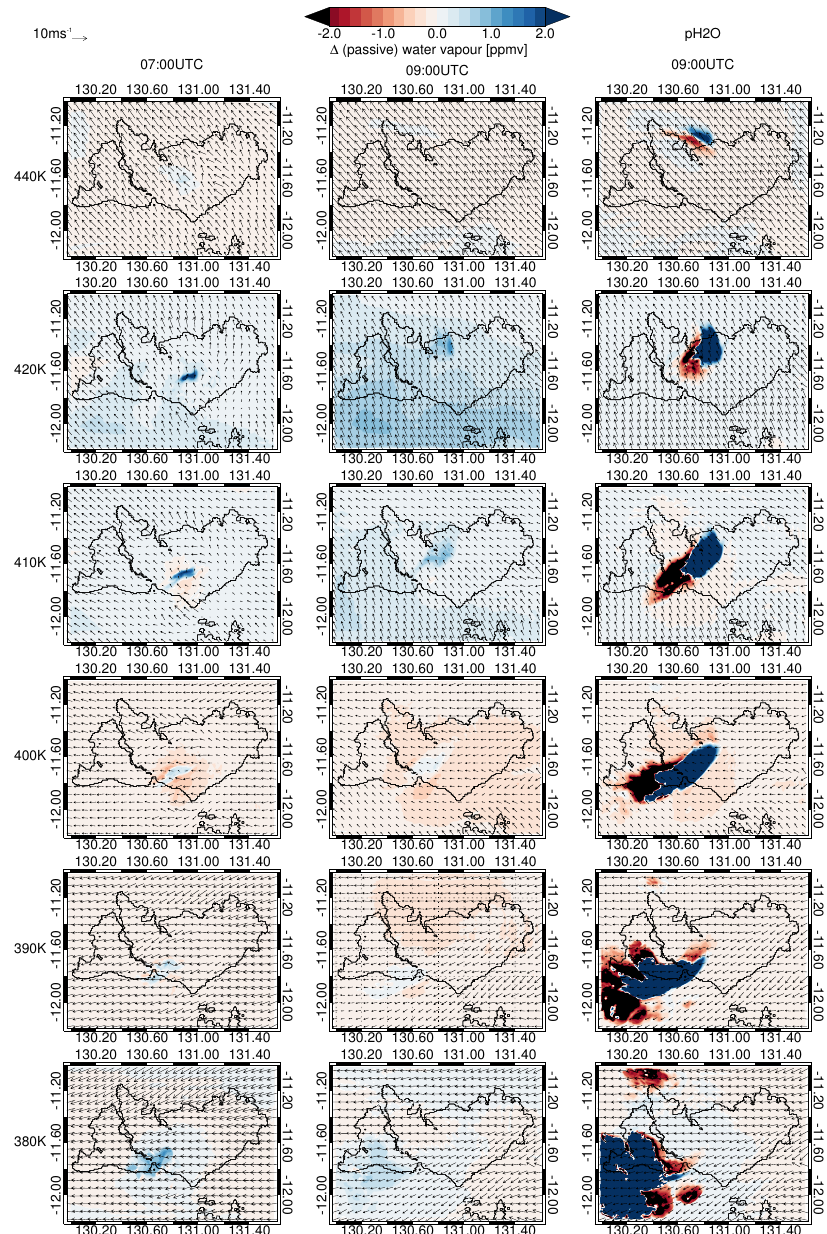
Figure 15. Change in humidity at 07:00UTC (left column) and 09:00UTC (middle column) on different potential temperature levels. The right column shows the change of p H 2 O at 09:00UTC for comparison. Superimposed are the horizontal wind vectors on the respective level.